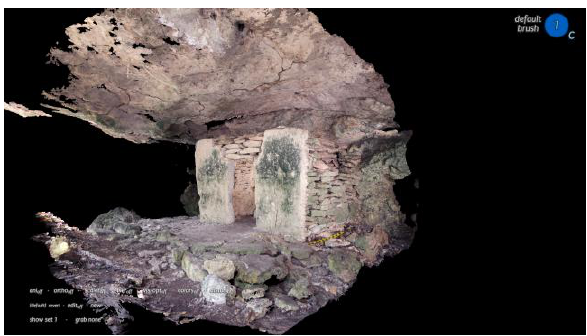
Figure 3. Point cloud (via SfM photogrammetry) of cave shrine XH-1 (note un-plastered sidewalls).